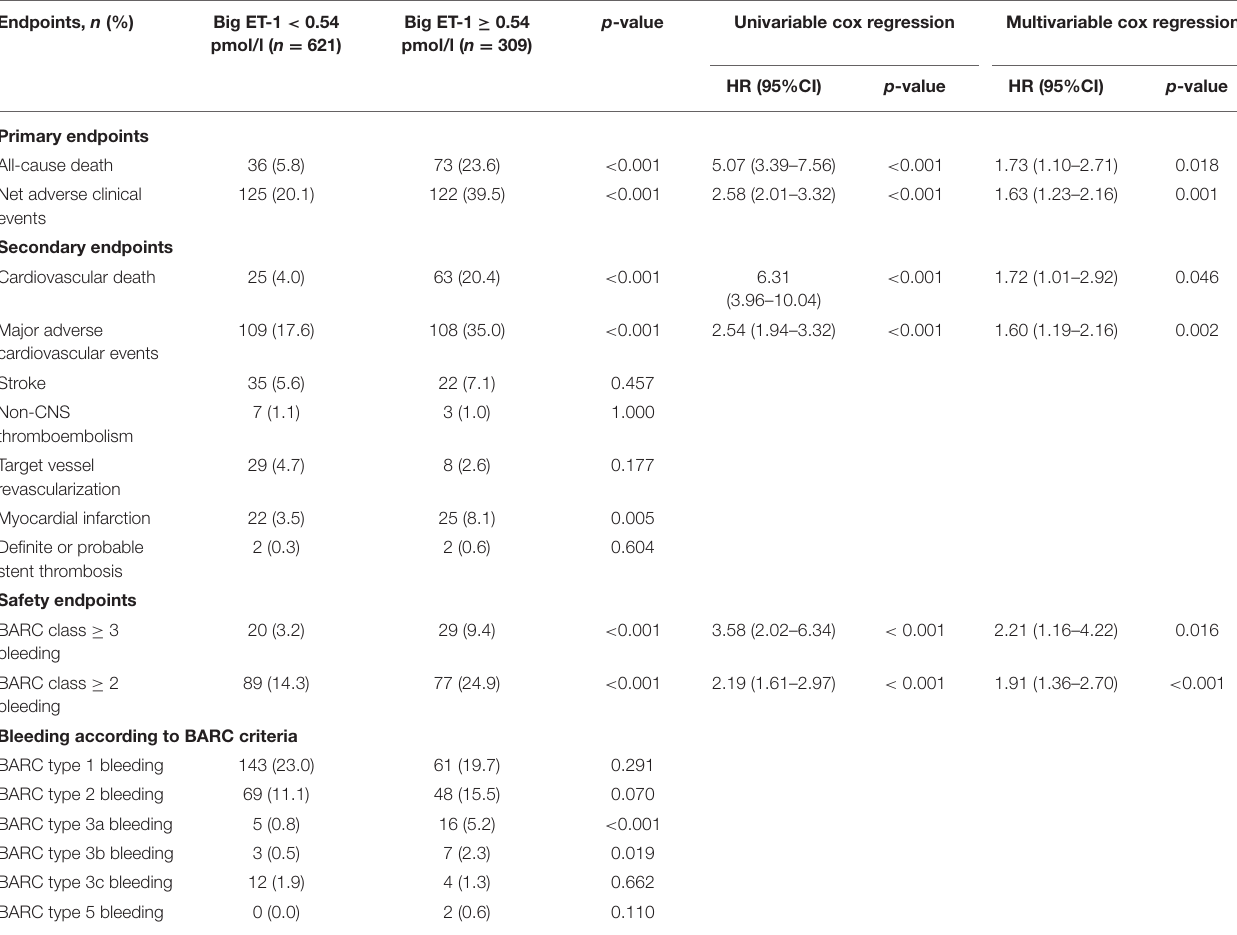
TABLE 3 | Association between plasma big ET-1 levels and long-term outcomes in patients with AF and ACS or undergoing PCI. Endpoints, n